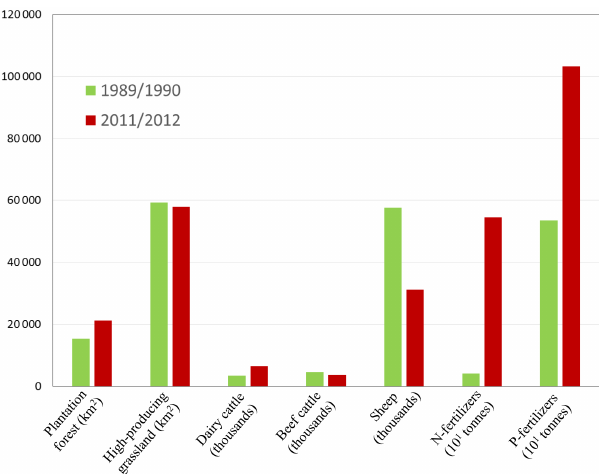
Figure 2. Changes in land use areal coverage, livestock, and fertil- izer inputs across New Zealand 1989/1990 vs. 2011/2012. Nitrogen fertilizers include urea and ammonium sulfate. Phosphorus fertiliz- ers include superphosphate and diammonium